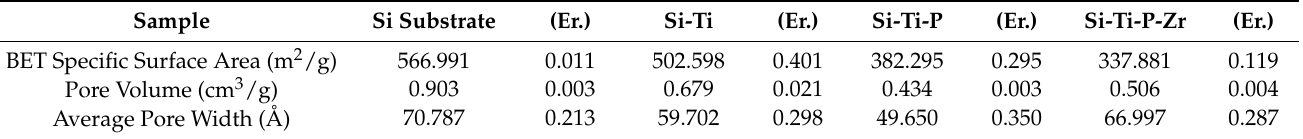
Table 1. BET surface area, pore volume, and average pore diameter by BJH adsorption